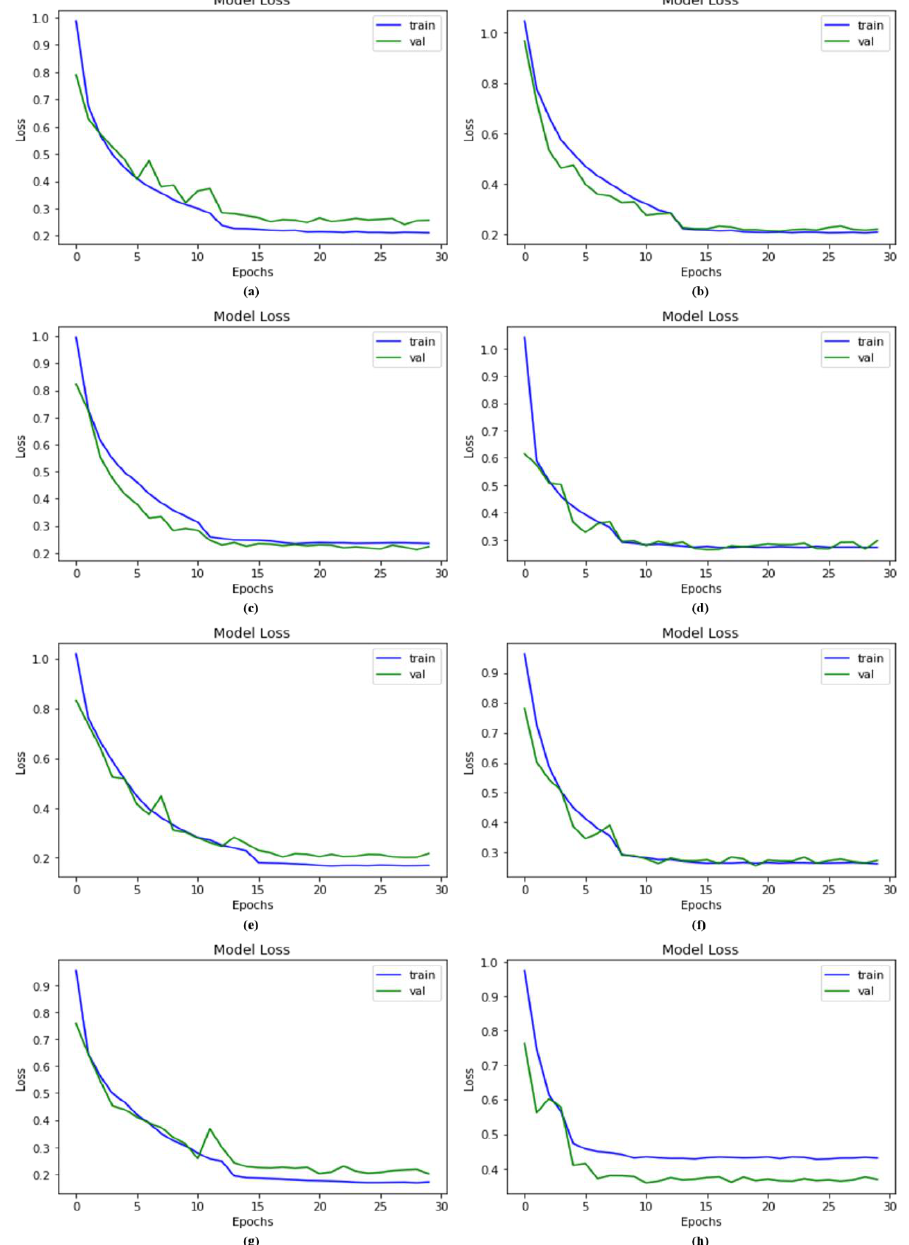
Figure 11. Loss value of the proposed DSCC_Net model and other baseline models; ( a ) Vgg-16, ( b ) Vgg-19, ( c ) EfficientNet-B0, ( d ) ResNet-152, ( e ) Inception-V3, ( f ) MobileNet, ( g ) Proposed Model with SMOTE Tomek, and ( h ) Proposed Model without SMOTE Tomek.